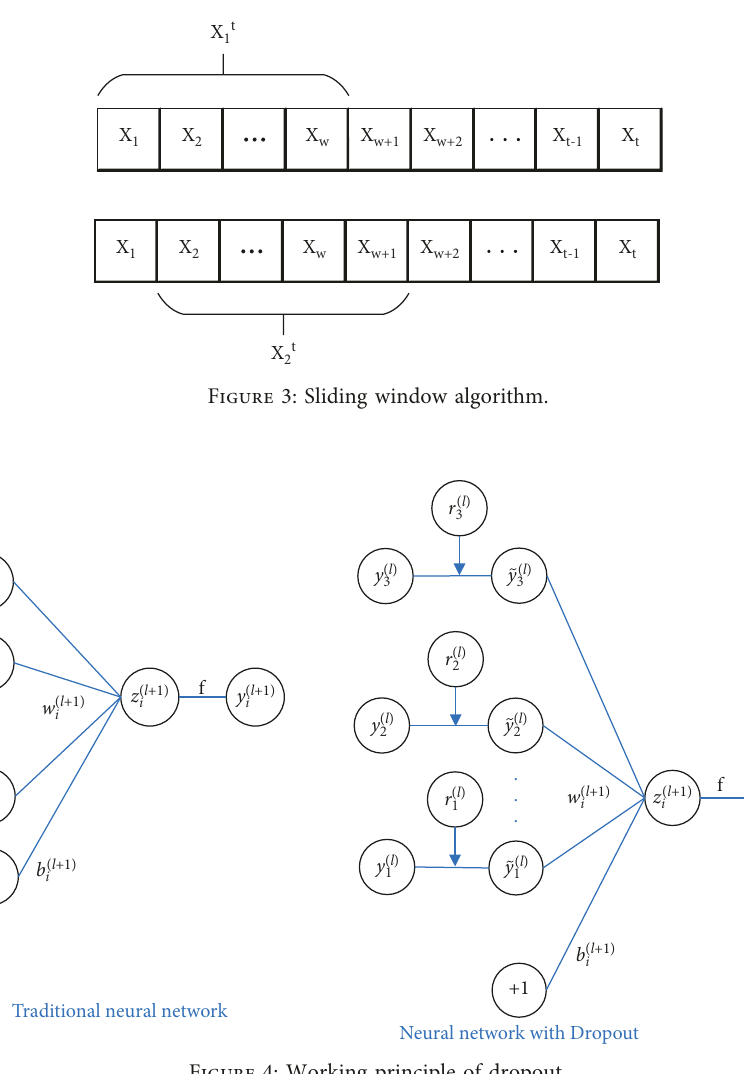
Figure 4: Working principle of